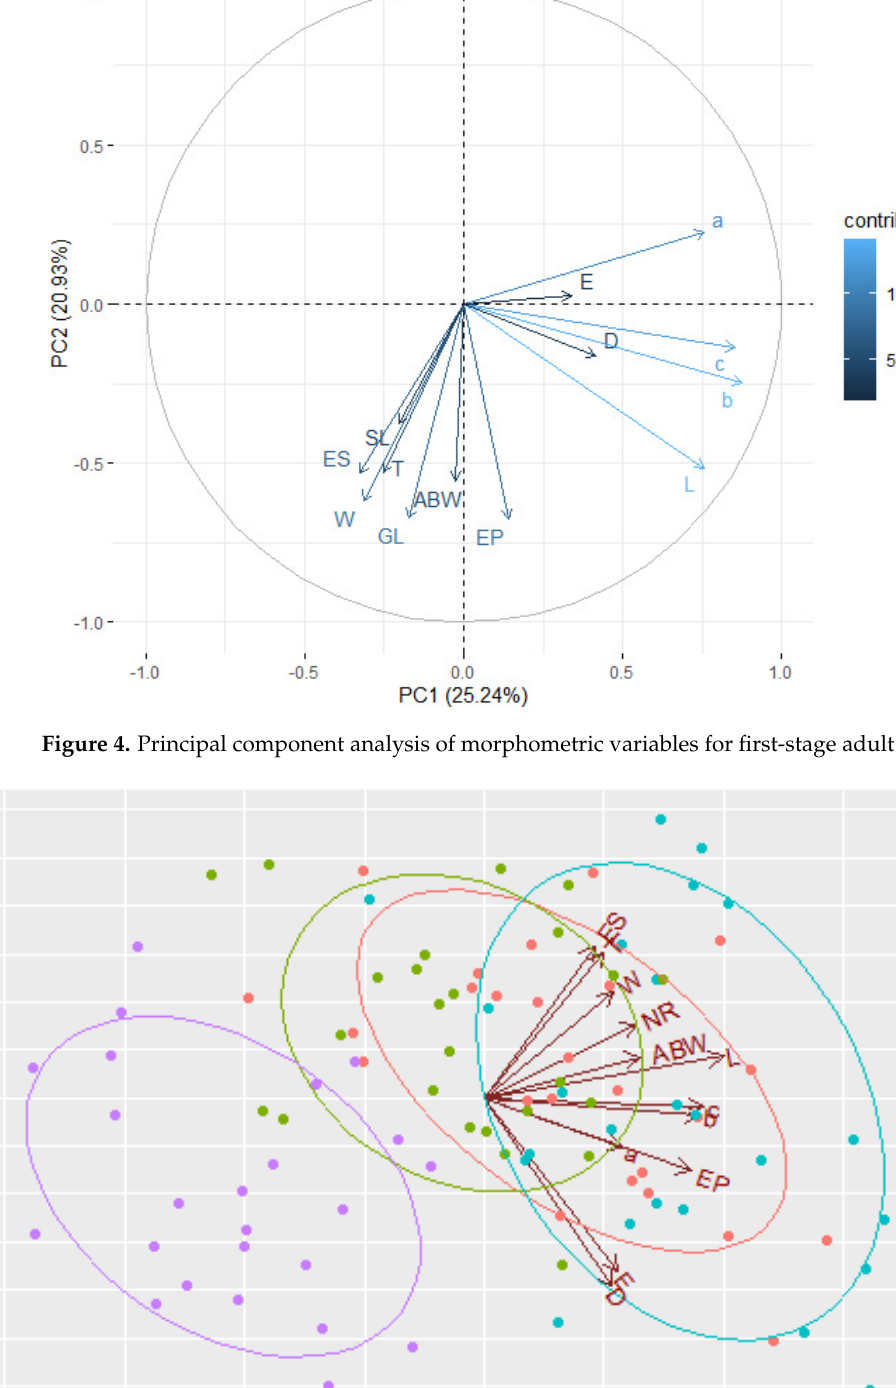
Figure 4. Principal component analysis of morphometric variables for first ‐ stage adult males.